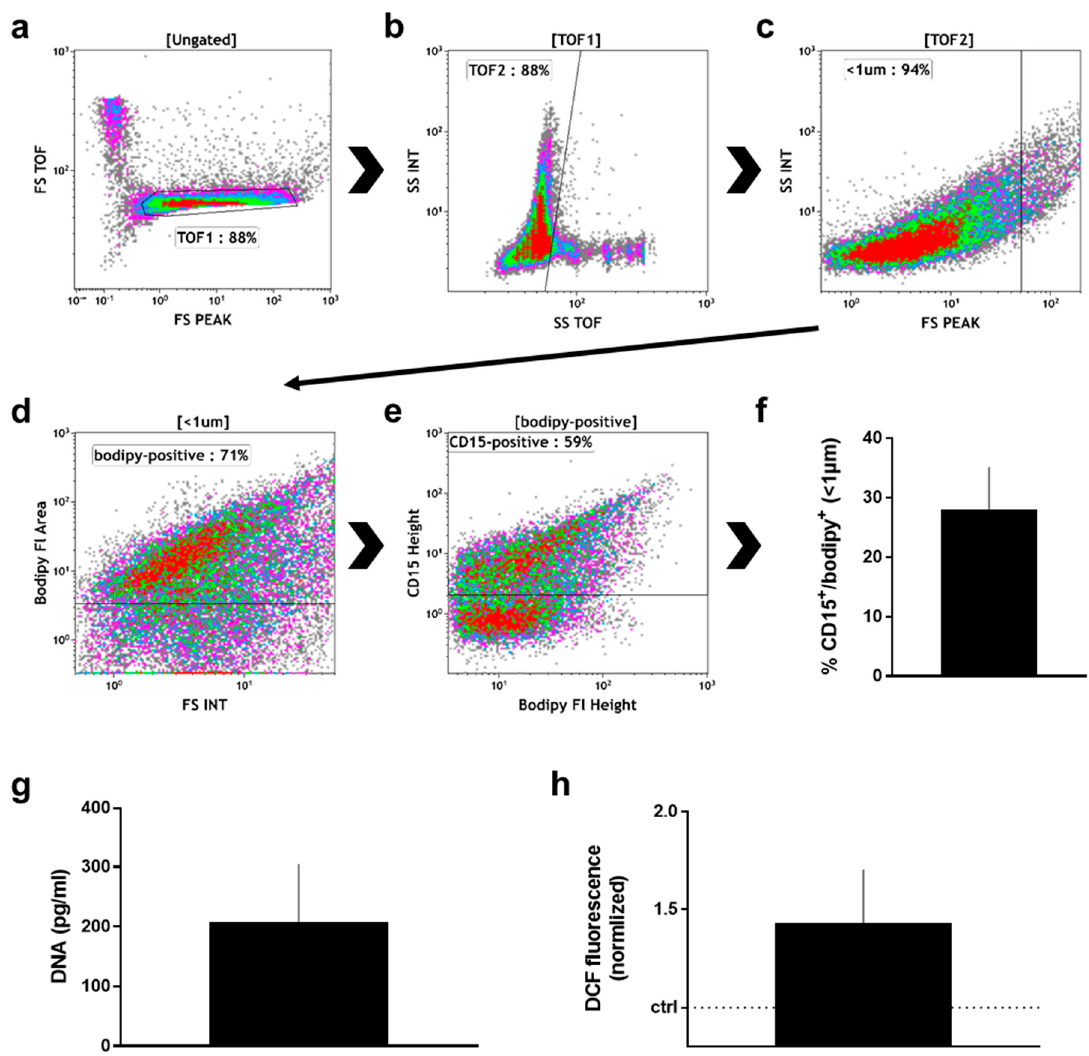
Figure 4. Supernatant analysis of manually removed wound material. ( a ) time of flight (TOF) gate in forward scatter (FS) height against FS TOF; ( b ) TOF gating analogous to ( a ); ( c ) size discrimination of small particles as predetermined with beads; ( d ) gate of membrane-positive particles as predetermined with unstained material; ( e ) discrimination between CD15 + and CD15 − microparticles as predetermined with unstained particles; ( f ) quantification CD15 + particles among all samples; ( g ) DNA content in supernatants as determined with sytox green against a known standard; ( h ) DCF fluorescence of wound material supernatant; data are one representative ( a – e ) or mean + S.E. of 8 ( f ), 3 ( g ), and 2 ( h ) samples.